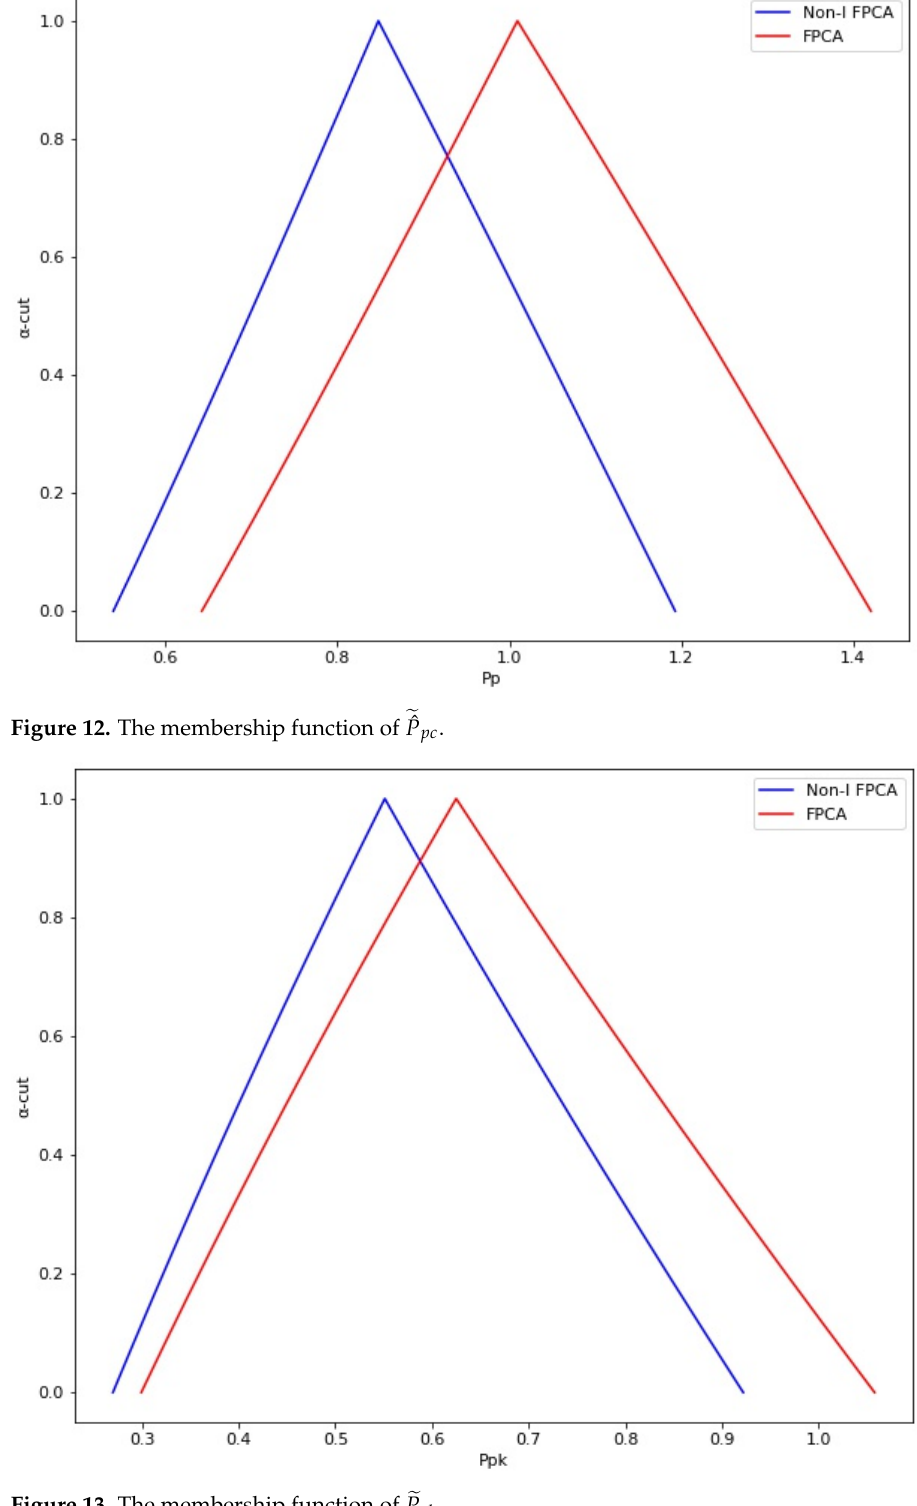
Figure 13. The membership function of (cid:101) P pkc .